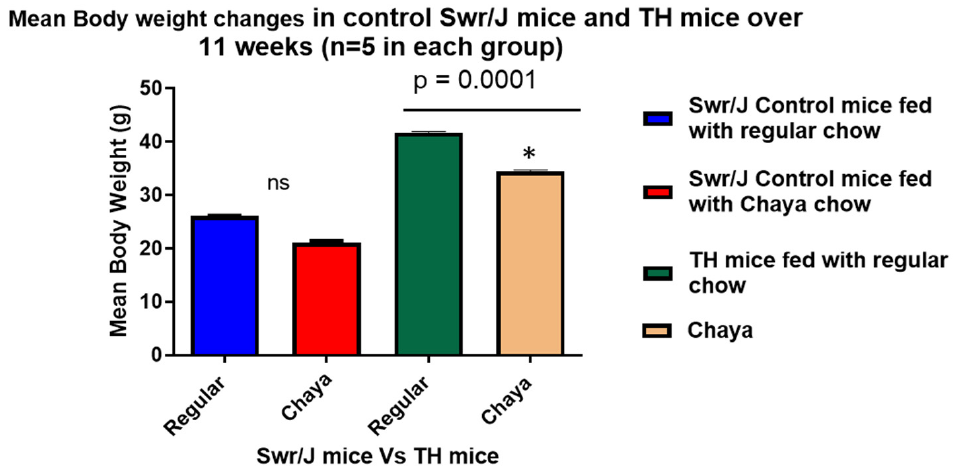
Figure 1. A comparison of the changes in body mass in the TH mice fed with chaya and TH mice fed with regular chow over a period of 11 weeks in relation to the SWR/J control mice with a statistical significance between the two TH mice groups ( n = 5, p = 0.0001). * p = 0.01.